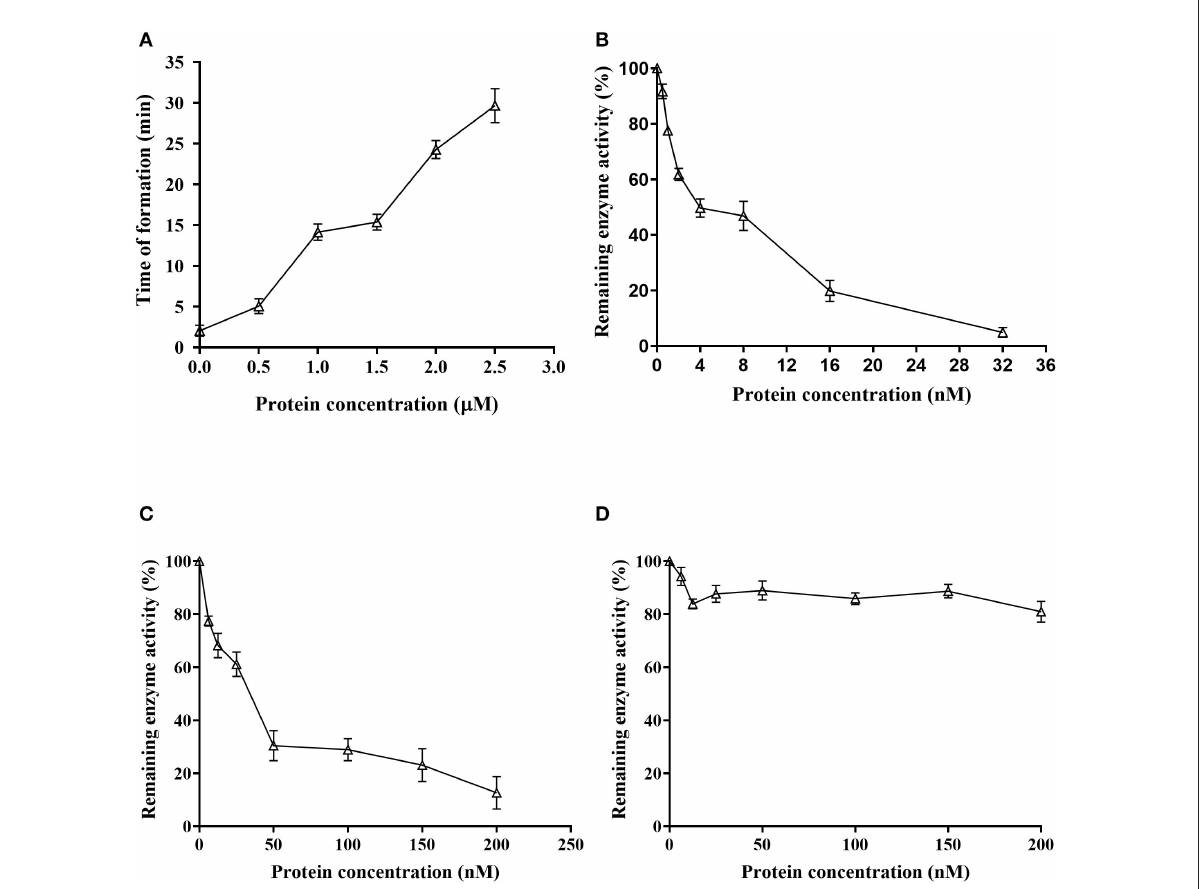
FIGURE6 Function analysis of Doenitin-1. (A) rDoenitin-1 coagulation time at different concentrations (0, 0.5, 1, 1.5, 2, and 2.5 µ M). Residual peptidase activity (%) of rDoenitin-1 on thrombin (B) , cathepsin G activity (C) and trypsin (D) by rDoenitin-1.